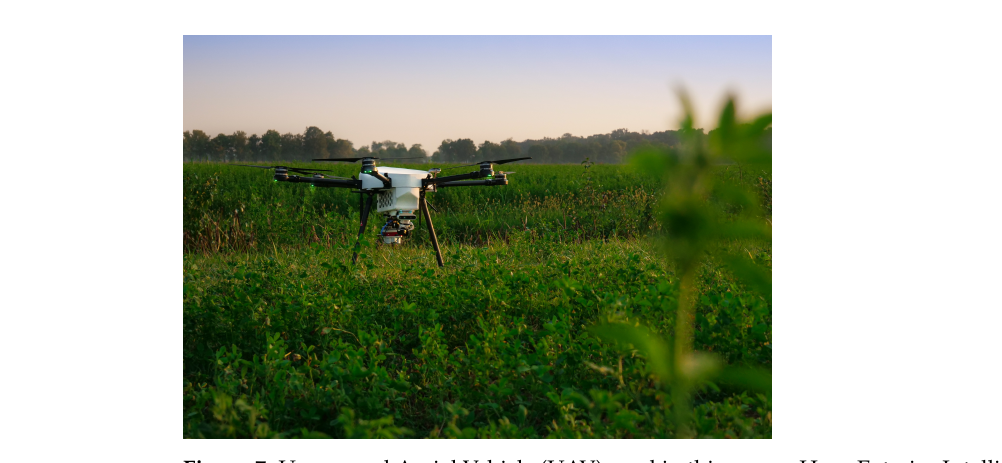
Figure 7. Unmanned Aerial Vehicle (UAV) used in this paper: Hexa Exterior Intelligent Flying Unit